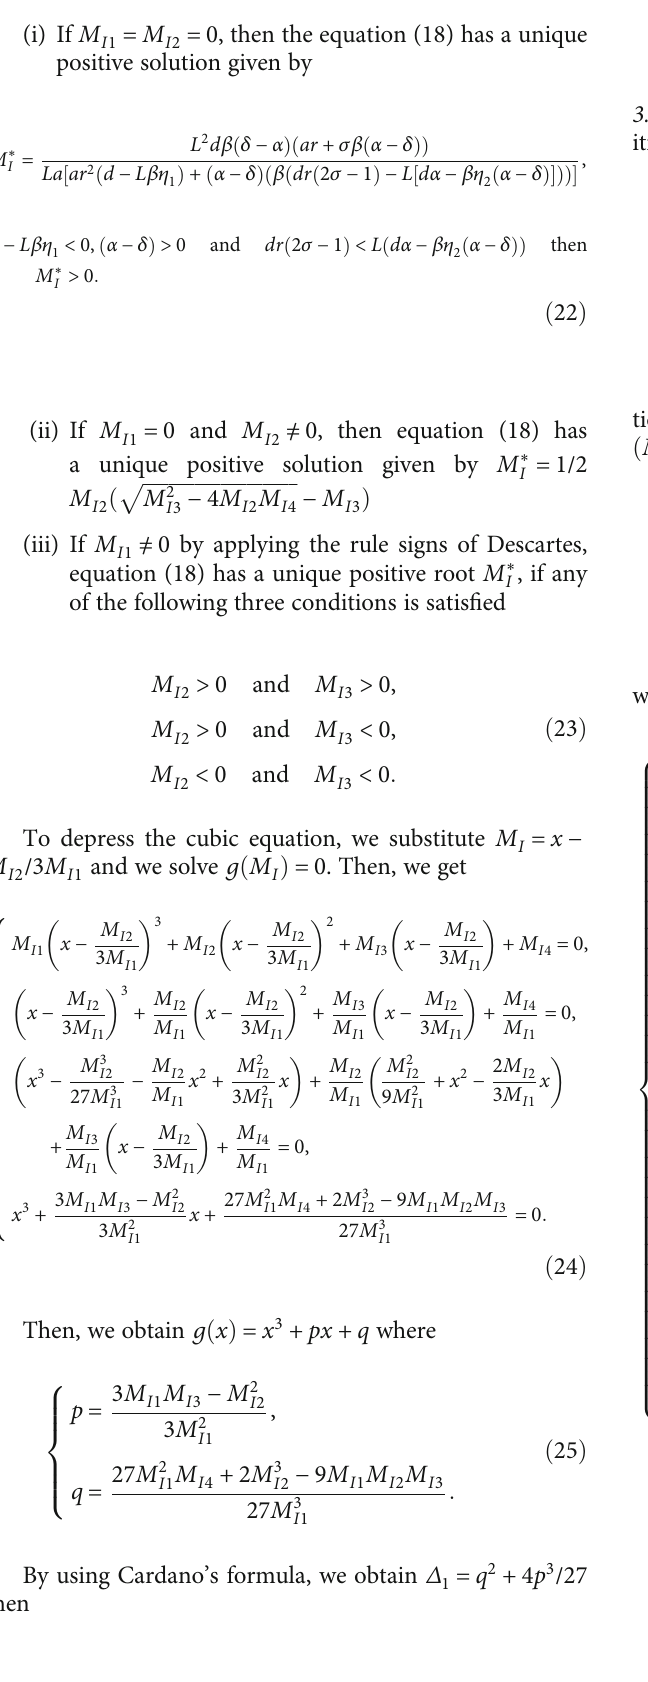
ffiffiffiffiffiffiffiffiffiffiffiffiffiffiffiffiffiffiffiffiffiffiffiffiffiffi q 2 + 4 p 3 /27 ð